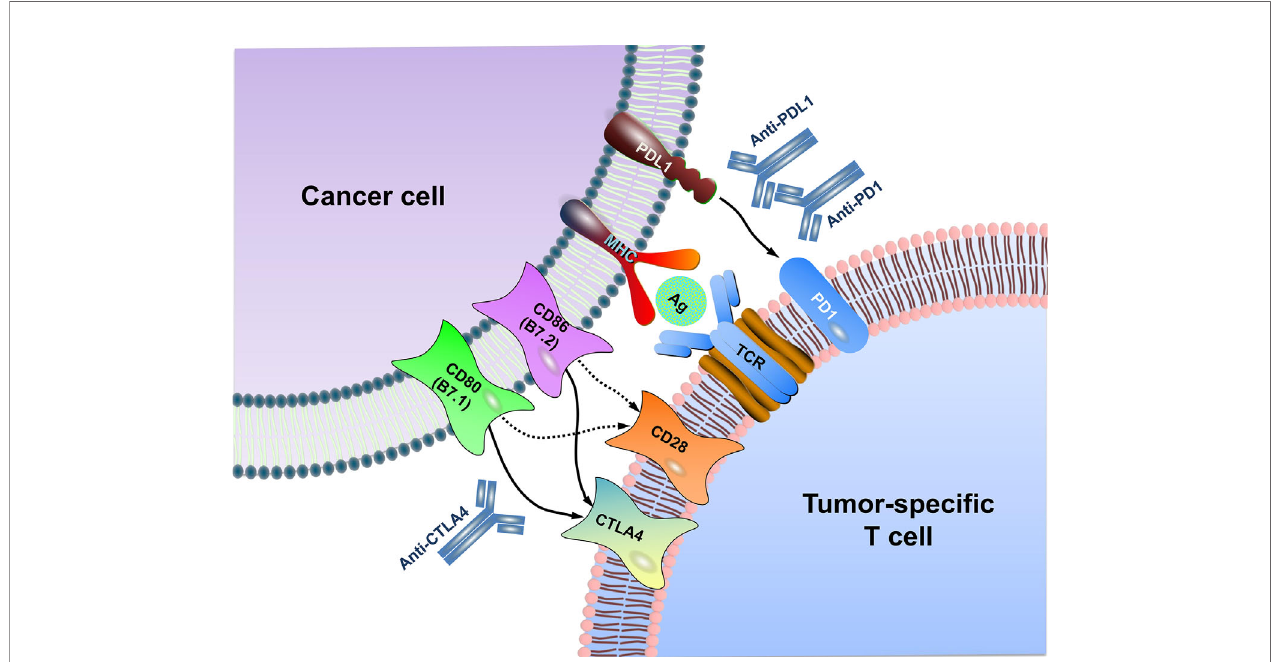
FIGURE 2 | Schematic diagram of immune checkpoint blockade. MHC generally presents antigen on the surface of cancer cells for recognition by CD8 + T cells via their TCR. CTLA4, as a negative regulator, is homologous to the T cell co-stimulatory protein CD28, both of which bind to CD80 and CD86 on the surface of cancer cell but with different af fi nity. Overall, CTLA4 has a much higher af fi nity than CD28 to CD80/CD86. PD1 is expressed on T lymphocyte surface. The binding of PD1 on the T cell with PDL1 functions to suppress signals downstream of TCR activation, leading to apoptosis of the CTL. Antibodies (anti-CTLA4, anti-PD1, anti-PDL1) inhibit these checkpoint targeting proteins to restore the activity of T cells and kill cancer cells. MHC, major histocompatibility complex; TCR, T cell receptor; Ag, antigen.